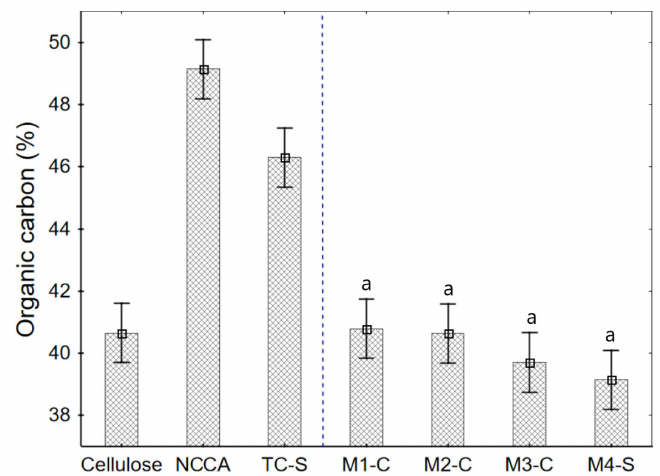
Figure 6. Organic carbon content in raw materials and